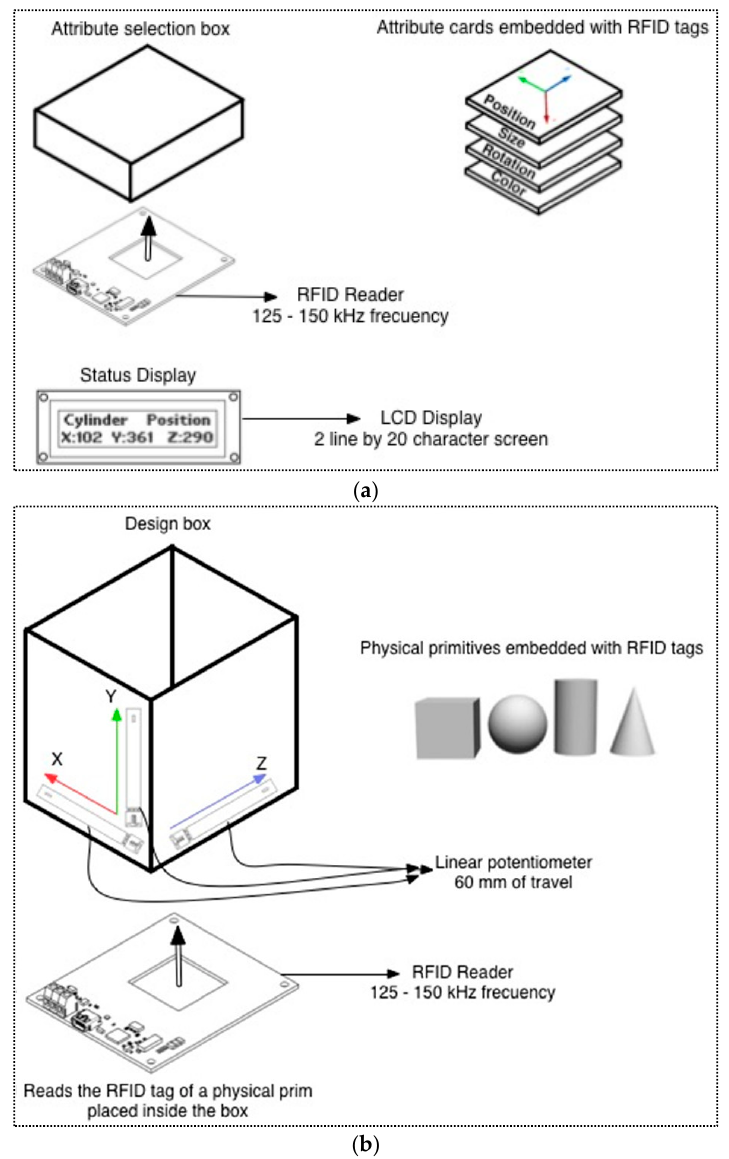
Figure 5. Design of Primbox. ( a ) Attribute selection box and attribute cards; ( b ) Desing box.